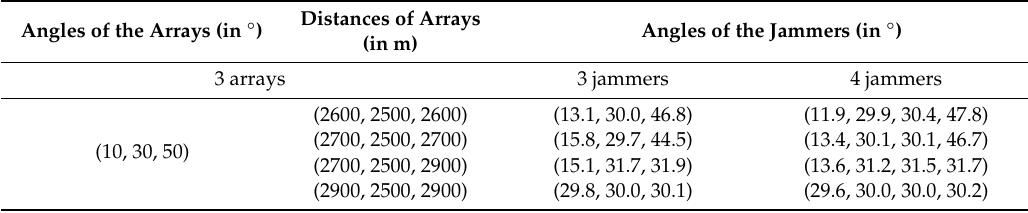
Table 3. Optimized angles of the jammers for di ff erent numbers of jammers with respect to the three-array networks with di ff erent distances in a single-target scene. Angles of the Arrays (in ◦ )